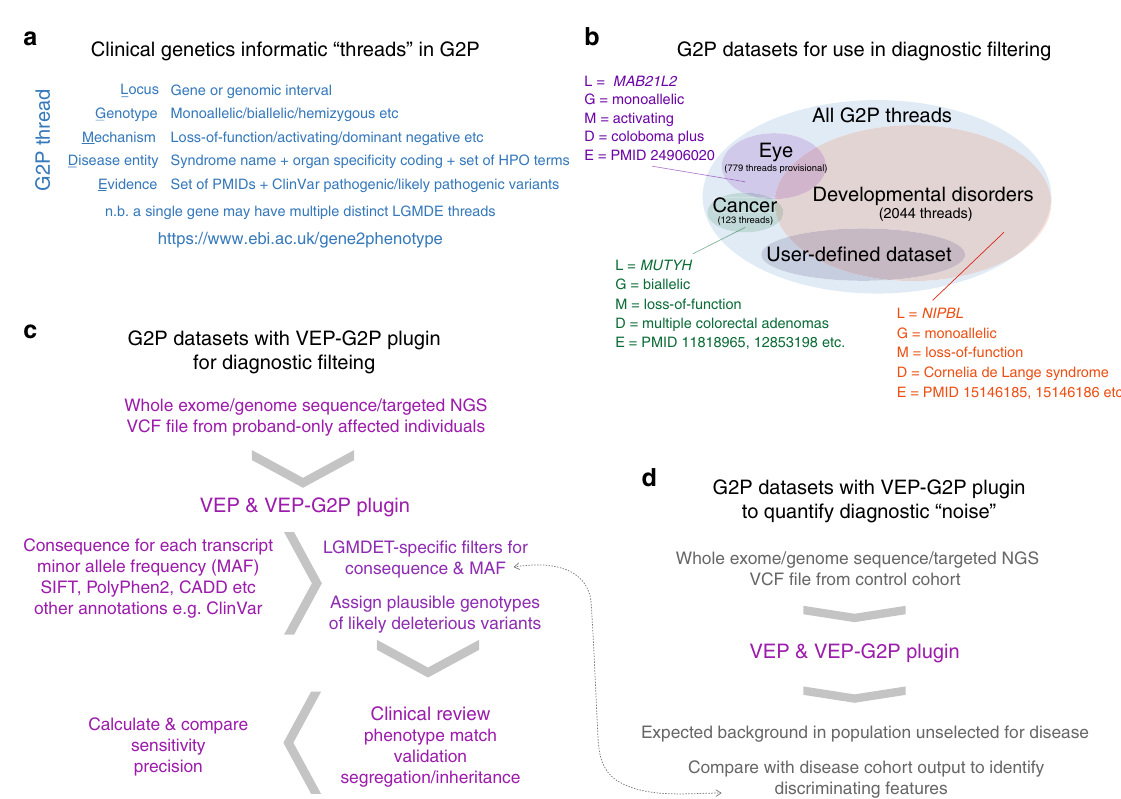
Fig. 1 Summary of LGMDET structure and application in diagnostic fi ltering. a summarizes the components of a LGMDET thread. Each locus-genotype- mechanism-disease-evidence thread (LGMDET) associates an allelic requirement and a mutational consequence at a de fi ned locus with a disease entity and a con fi dence level and evidence links. The publicly available G2P DD and G2P Cancer data can be searched or downloaded on the website (https://www. ebi.ac.uk/gene2phenotype). b gives examples for LGMDE threads from curated datasets. In addition to the publicly available G2P DD and G2P Cancer